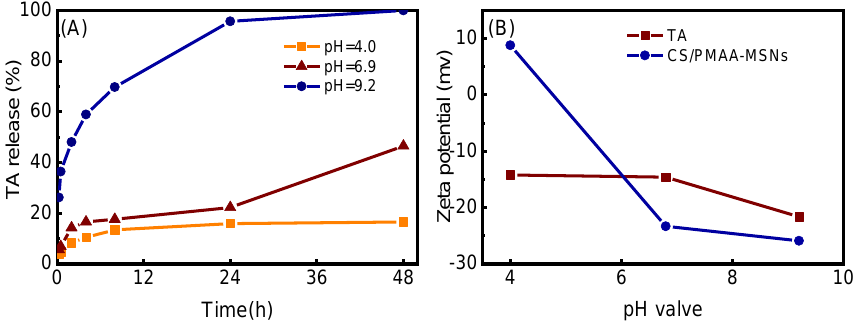
Figure 9. ( A ) Release profiles of TA from CS/PMAA-MSNs@GO composite microspheres at pH values of 4.0, 6.9, and 9.2; ( B ) zeta potential of TA and CS/PMAA-MSNs@GO at different pH.